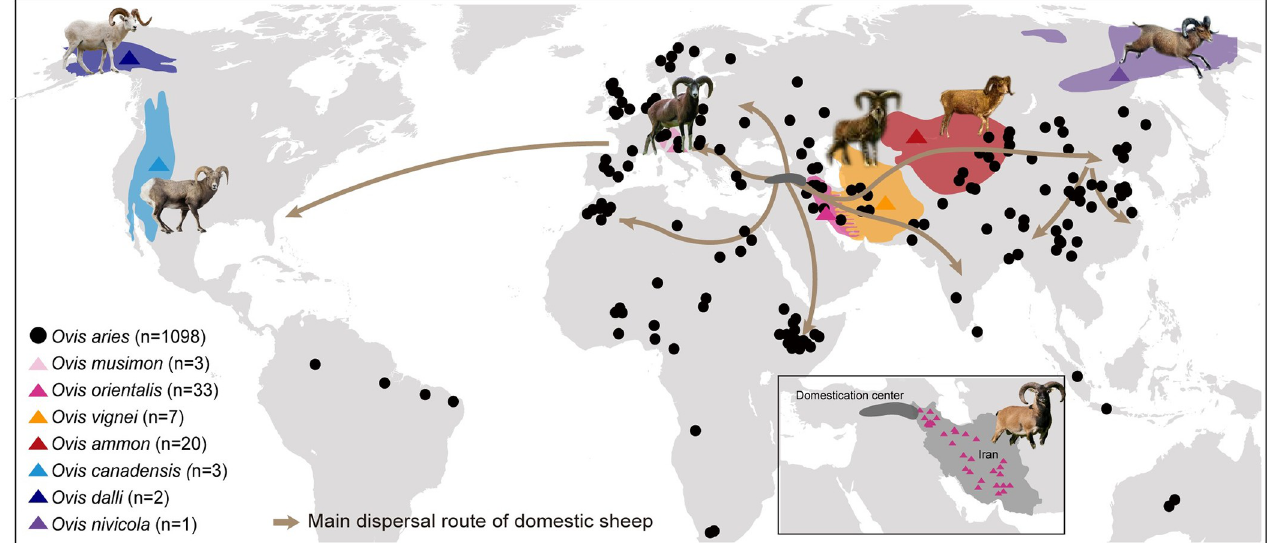
Fig 1. Locations of different geographically wild Ovis species and diverse domestic sheep populations used in this study. The colored blocks show the geographic distributions of the wild species. And each black dot represents a domestic breed. The dark grey block means the domestication center of sheep, and the solid lines represent dispersal routes of domestic sheep out of their domestication area [20–22]. The map base layer and photo credits using in this figure are showed in S7 Table. https://commons.wikimedia.org/wiki/File:Polio_worldwide_2012.svg.